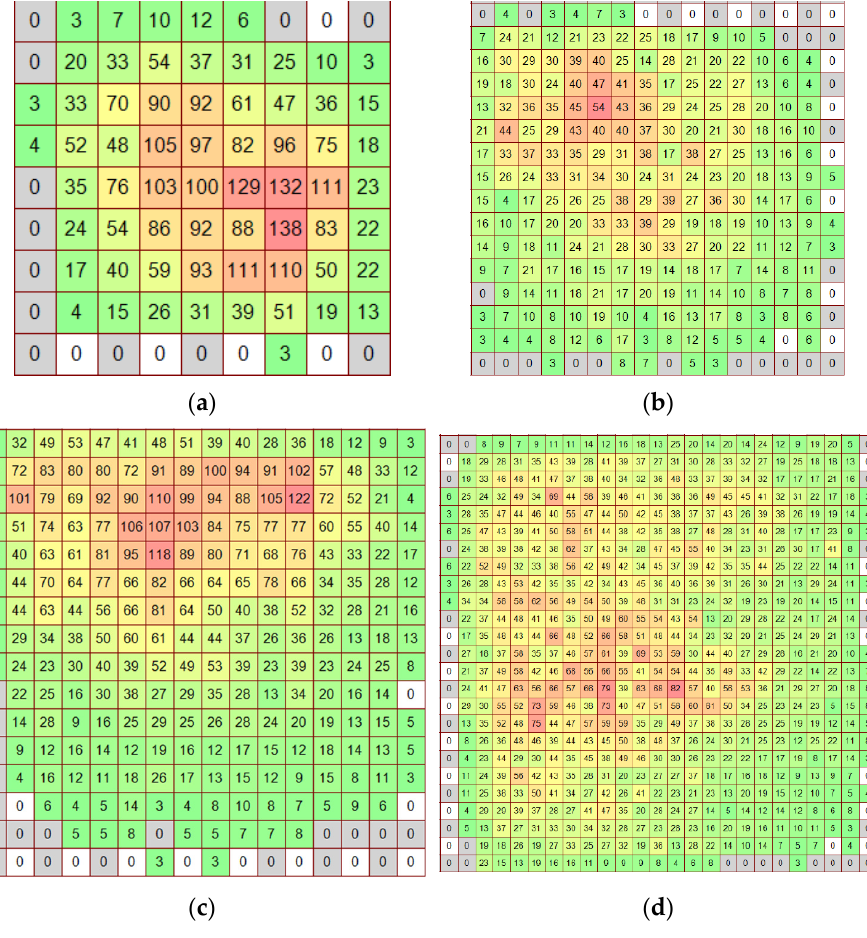
Figure 4. Examples of raw pressure patches at dead weight loading of 5051 ‐ 350 sensor (regime s29) on various pads: ( a ) 2 kg 1 cm 2 ; ( b ) 2 kg 4 cm 2 ; ( c ) 5 kg 4 cm 2 ; ( d ) 10 kg 9 cm 2 . Green color of cells corresponds to low pressure, yellow—to average pressure, red—to high pressure.